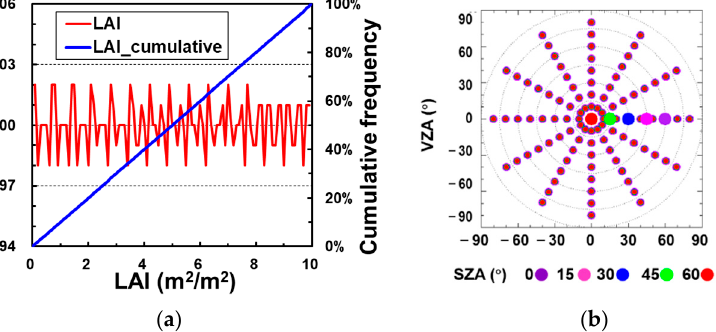
Figure 1. Distribution of the vegetation parameters and observation geometry for the PROSAIL simulations: ( a ) uniform distribution of the LAI; ( b ) angle sampling of the PROSAIL simulations.